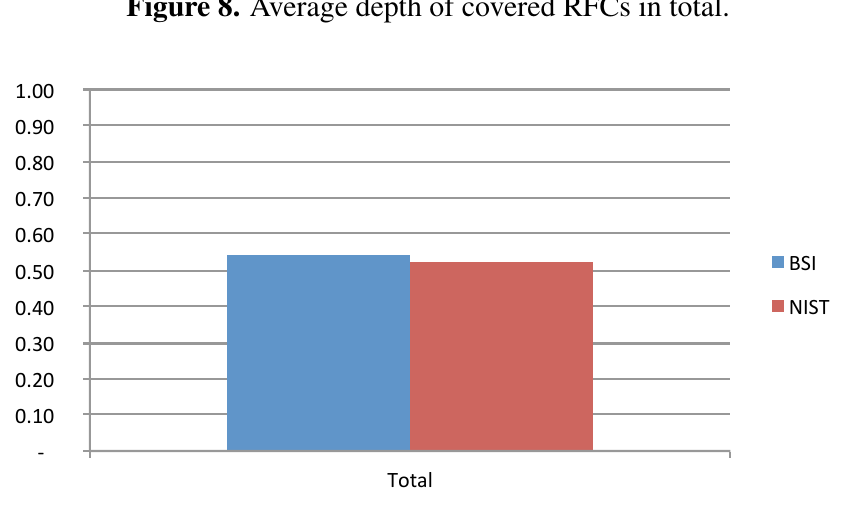
Figure 8. Average depth of covered RFCs in